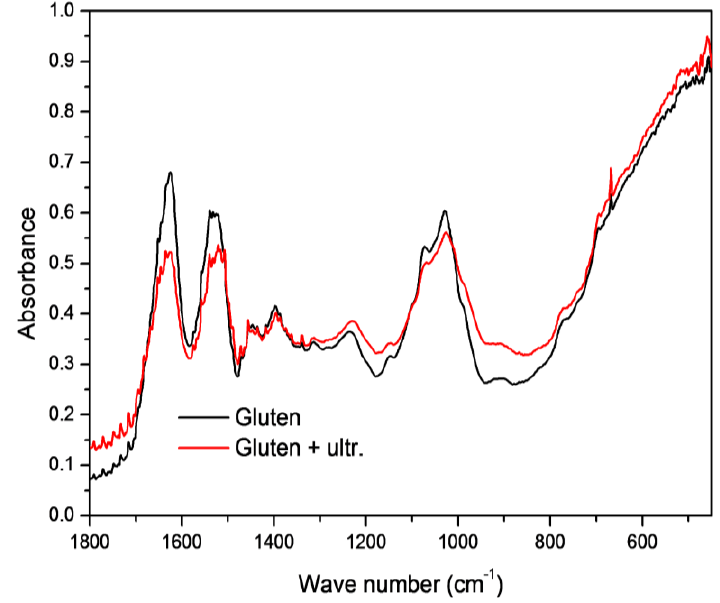
Figure 3. Raman spectra of unsonicated and sonicated gluten obtained from wheat cultivated in the organic system with barley as a forecrop.